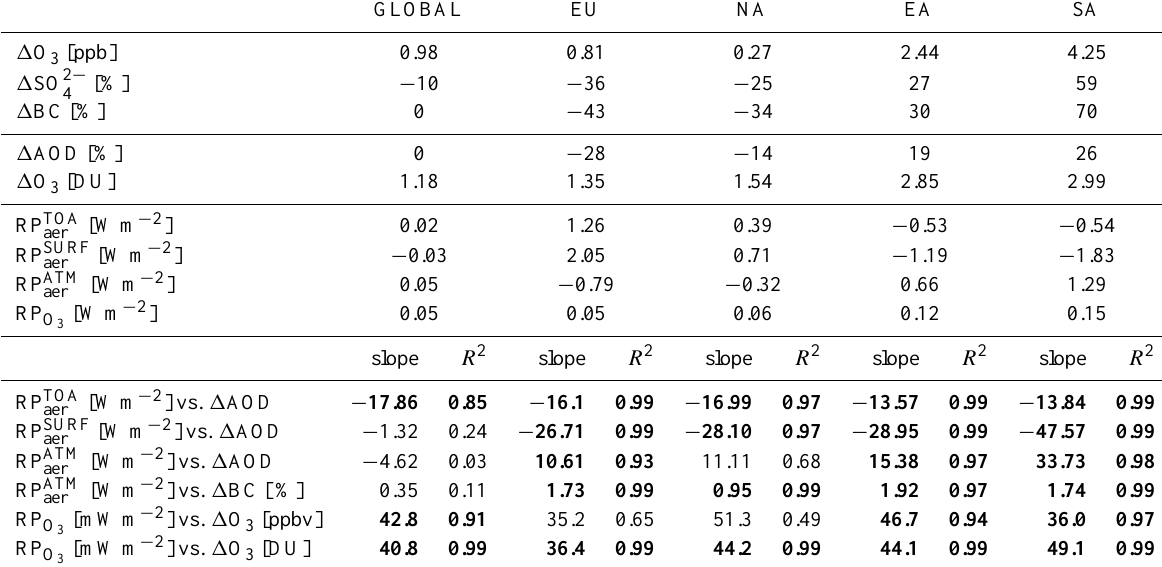
Table 5. Globally and regionally (EU, NA, EA, and SA) averaged effect of changing anthropogenic emissions (SREF-SFIX) during the 5-yr periods 1981–1985 and 2001–2005 on: surface concentrations of O 3 (ppbv), SO 2 − and total column O 3 (DU); the total anthropogenic aerosol radiative perturbation at top of the atmosphere (RP TOA aer ), at surface (RP SURF aer ) (Wm − 2 ), and in the atmosphere (RP ATM aer = (RP TOA aer − RP SURF aer ); the anthropogenic radiative perturbation of O 3 (RP O lated over the entire period 1980–2005 between anthropogenic RP TOA aer and 1 AOD; between anthropogenic RP SURF aer and 1 AOD; between RP ATM aer and 1 AOD; between RP ATM aer and 1 BC; between anthropogenic RP O column. High correlation coefficients are highlighted in